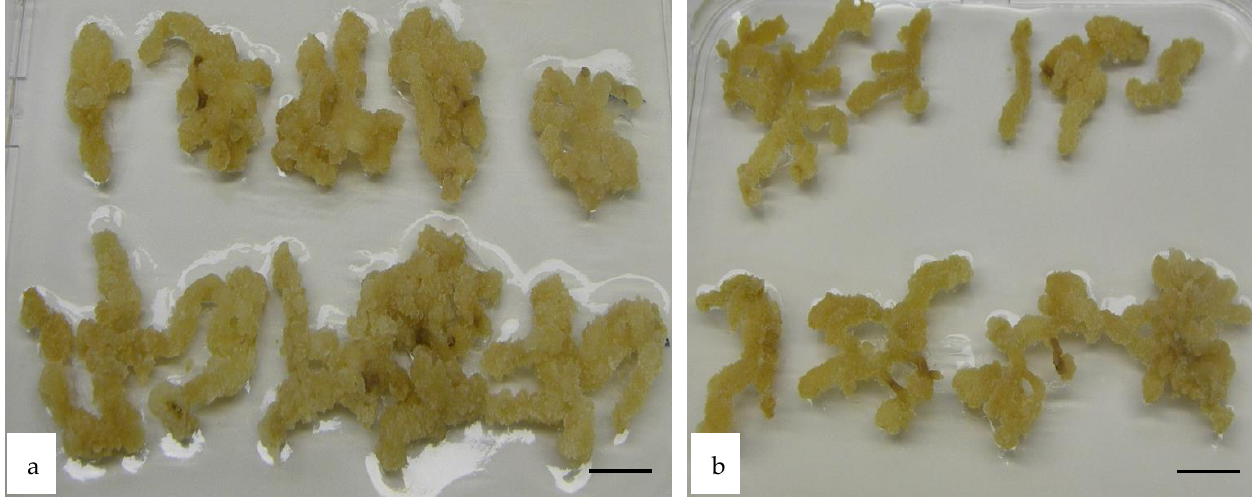
Figure 6. Callus production from Medicago truncatula hairy root (HR) explants. Callus production from Medicago truncatula leaf explants, transformed with pCambia1301- WUS-BAR, two weeks after their transfer to M0 medium (without growth regulator). These calli were produced on a callogenesis medium C (5 mg · L − 1 2,4 -D and 0.5 mg · L − 1 BAP) in the dark for two weeks ( a ) or under photoperiod on M1 medium (50 mg · L − 1 NAA and 1.5 mg · L − 1 BAP). Scale bar 1.0 cm ( b